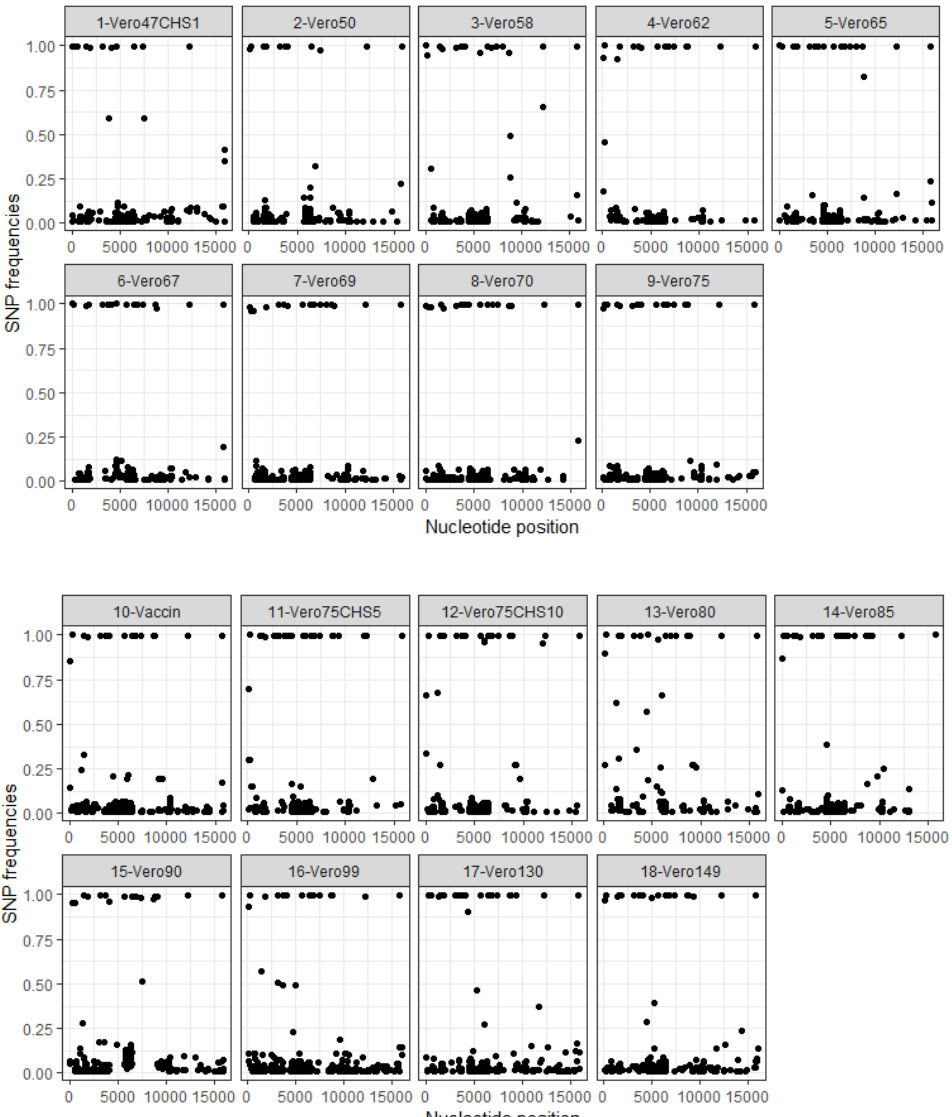
Figure 2. Distribution of SNP frequencies according to positions in the genome. SNP: Single nucleotide polymorphism. Position: PPRV genome from 0 to 15,948 bp. The Vero47CHS1 passage represents 47 passages on the Vero cells and one passage on the CHS cells. The Vero75CHS5 passage represents 75 passages on Vero cells and five passages on CHS cells.